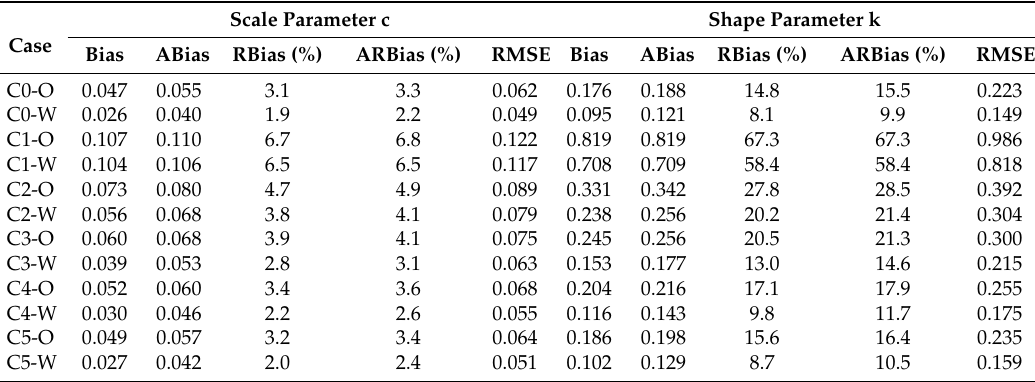
Table 4. Means of the evaluation criteria for the downscaled Weibull parameter estimates based on parameter estimates of the observed Weibull distribution of all the